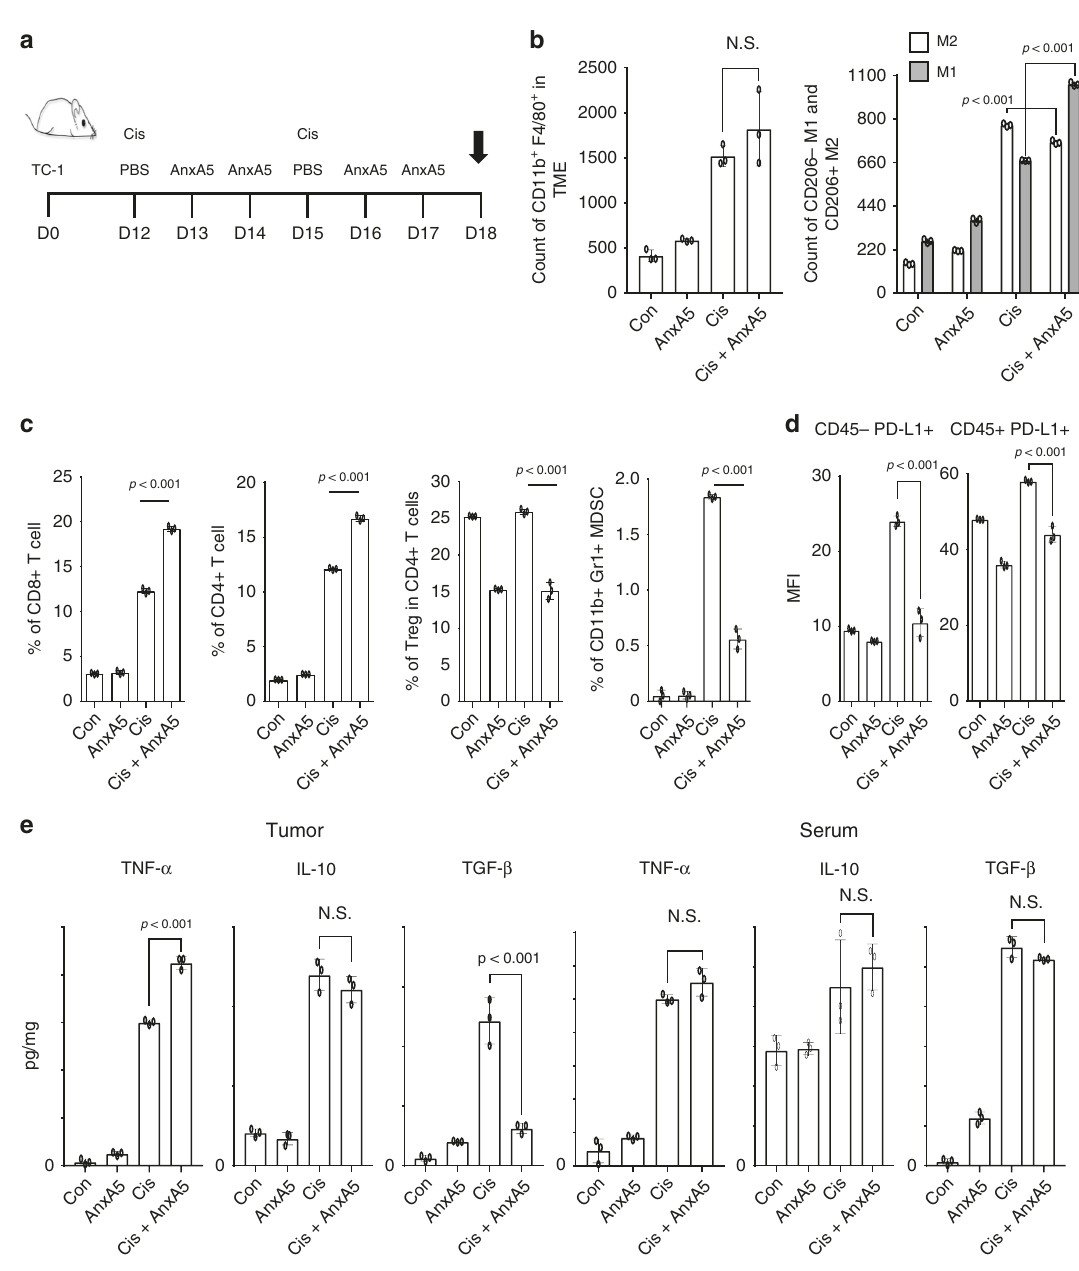
Fig. 2 Characterization of tumor microenvironment following Annexin A5 treatment. C57BL/6 mice (10 per group) were injected with 2 × 10 5 TC-1 cells/ mouse subcutaneously on day 0. Mice were then treated intraperitoneally with 5 mg/kg Cisplatin on days 12 and 15, and/or intravenously with 200jig/ mice of Annexin A5 proteins on days 13, 14, 16, and 17. PBS was used as control. On day 18, tumor tissues and serum of mice were harvested. a Schematic diagram. b Bar graphs depicting the abundance of CD11b + F4/80 + macrophages and their M1/M2 distributions in the tumor tissue following fl ow cytometry analysis ( n = 3). c Bar graphs depicting the presence of CD8 + T cells, CD4 + T cells, Treg cells, and MDSCs in the tumor tissue following fl ow cytometry analysis ( n = 3). d Bar graphs depicting the expression of PD-L1 by CD45 + immune cells and CD45- tumor cells following fl ow cytometry analysis ( n = 3). e Bar graphs depicting the levels of TNF- α , IL-10 and TGF-3 cytokines in the tumor tissue and serum of mice as measured by ELISA ( n = 3). The error bars indicate mean ± SD. N.S. = not signi fi cant. For ( b – e ), P -values were analyzed by Student ’ s t test. The results are representative of one of three independent experiments. Source data are provided as a Source Data fi